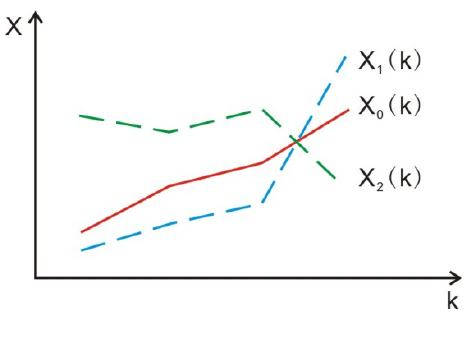
Figure 4. Similarity and difference of